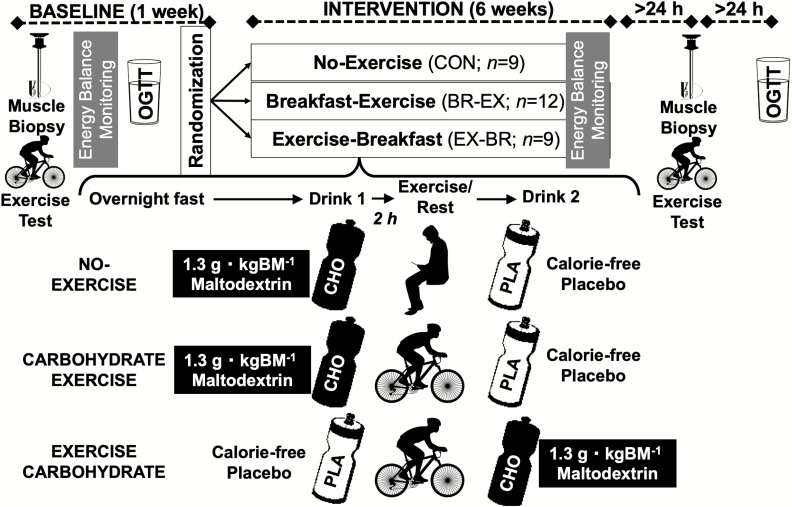
Protocol schematic for the Training Study.